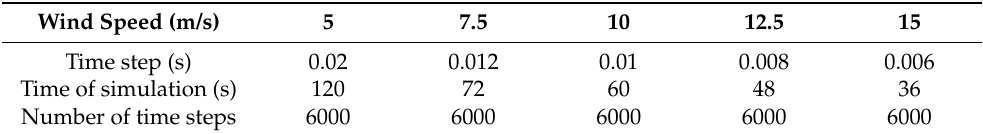
Table 1. Time step and a total time of simulation used depending on the flow speed.